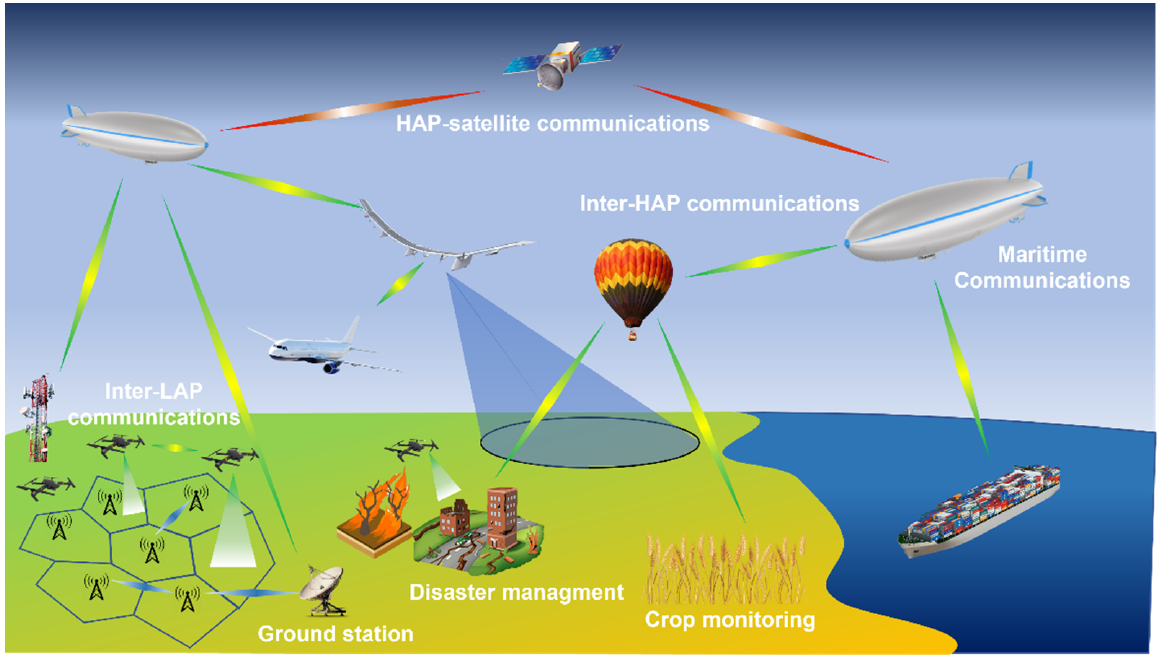
Figure 1. Example of a VHetNet scenario by considering some space, air and ground network components as envisioned in 6G wireless communications.